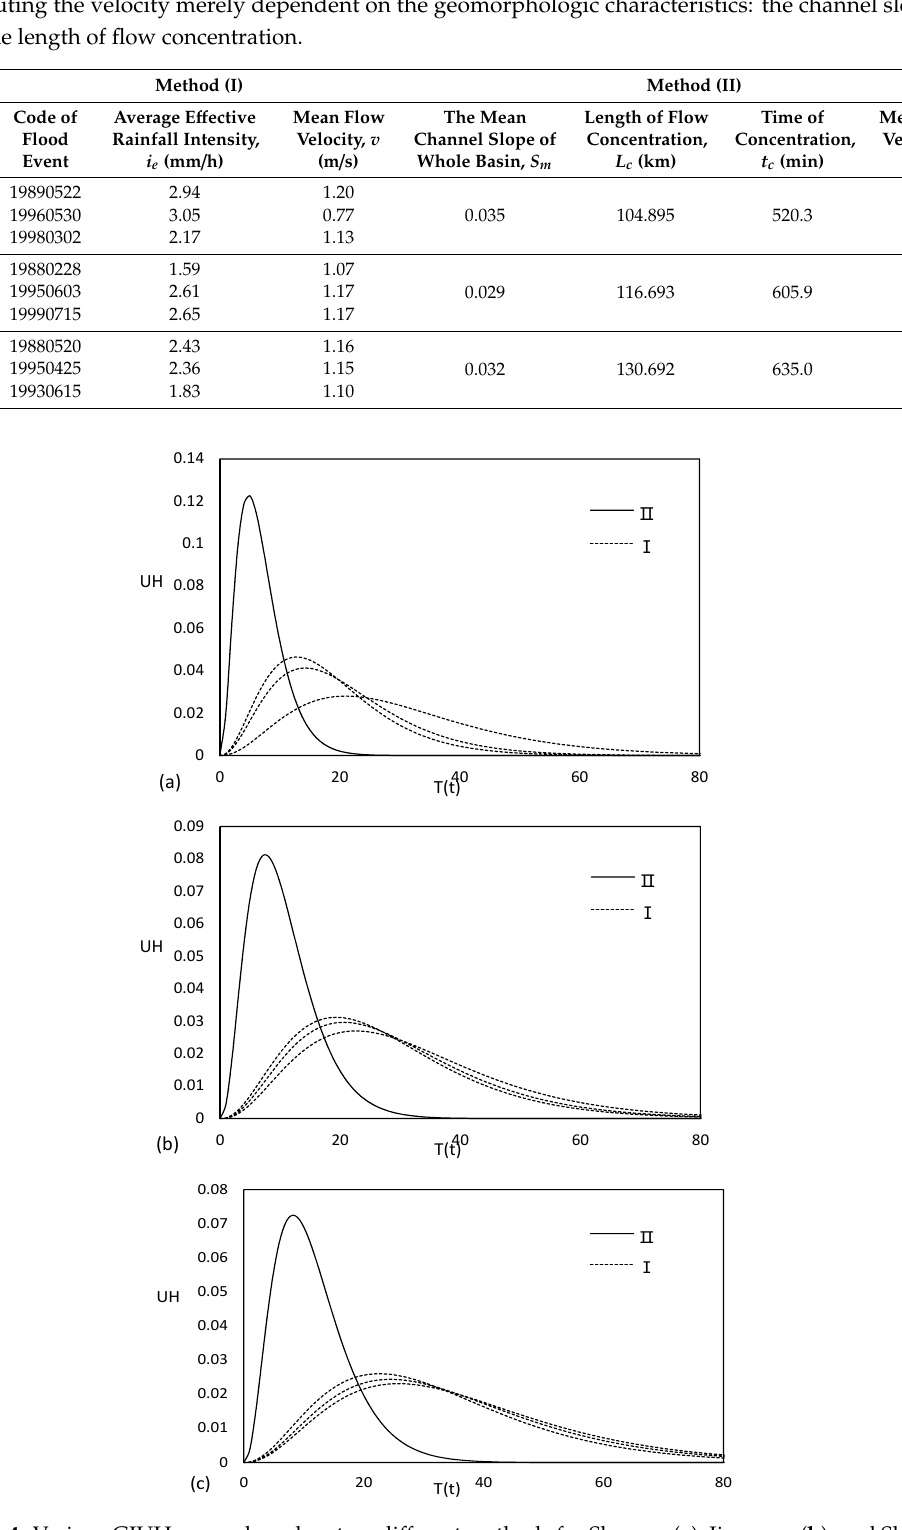
Figure 4. Various GIUH curves based on two different methods for Shaowu ( a ); Jianyang ( b ); and Shuiji ( c ) watersheds, with the dotted line curves standing for method (I), and the solid lines for method (II).